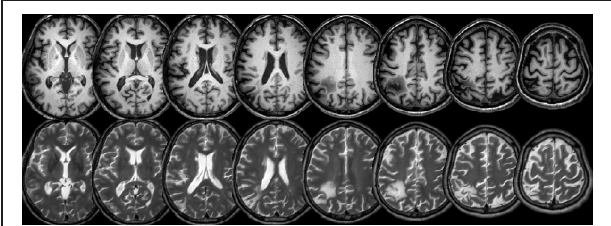
corresponding to the left side of the brain). Both the T1 (top row) and T2 (bottom row) images have been normalized to MNI stereotaxic space, with slices corresponding to Z = 8, 16, 24, 32, 40, 50,